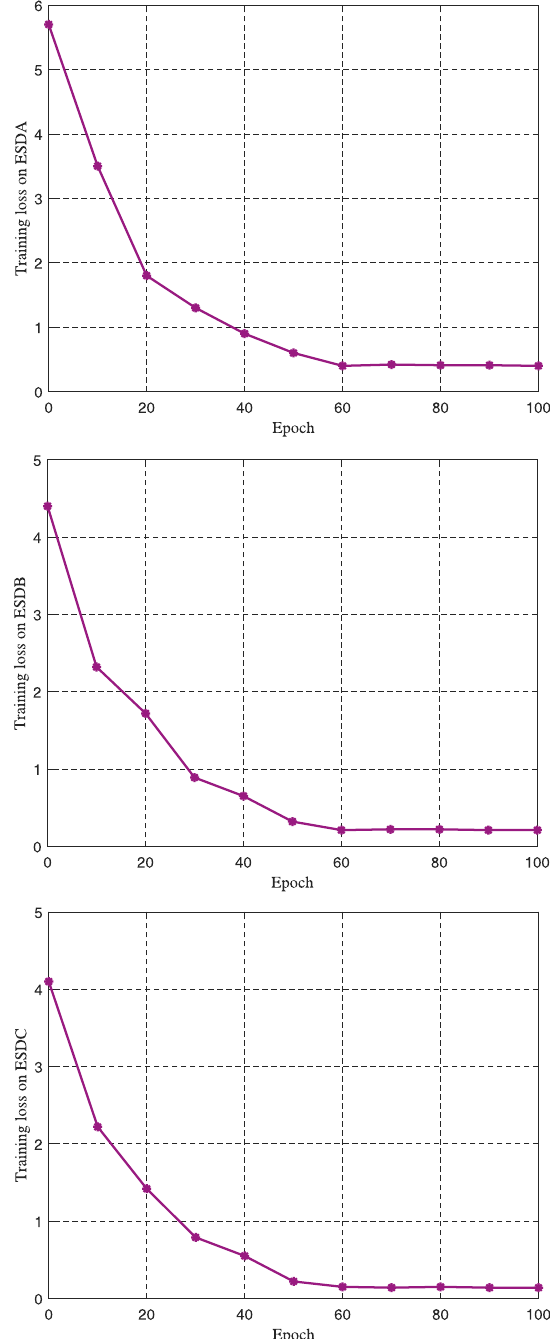
Fig. 11 Training loss of HATT-CNN-BiLSTM on ESDA and